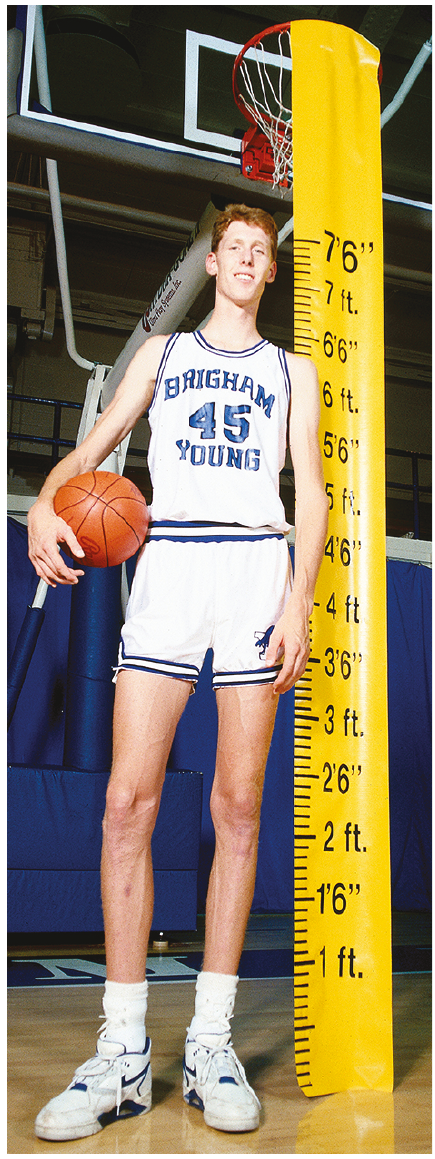
Figure 1: Shawn Bradley is 2.29m (7 ′ 6 ″ ) tall with no known medical conditions. Mr. Bradley played basketball for Brigham Young University from 1990 to 1991. He played in the National Basketball Association from 1993 – 2005. Photo courtesy of BYU